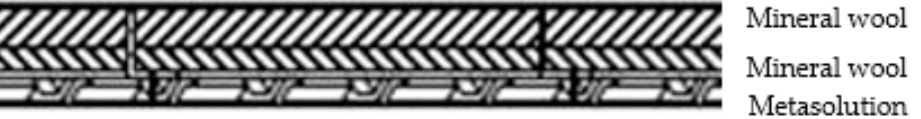
Figure 11. Scheme of the deck covering assembly in the two configurations (image adapted from technical report).